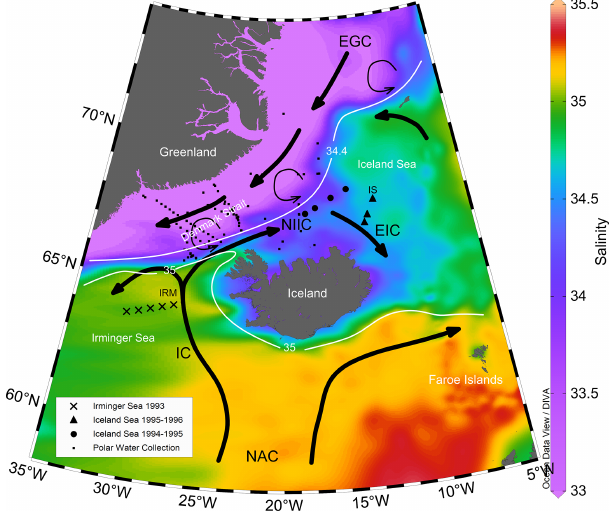
Figure 1. Mean July to September surface salinity in the vicin- ity of Iceland. The S = 35 isohaline marks the boundary between northward-flowing Atlantic Water and southward-flowing cold Arc- tic Water and low-salinity Polar Water. Stations in the Irminger Sea are marked with × , and stations in the Iceland Sea are marked with • for 1994–1995 and (cid:78) for 1995–1996 observations. Collection of Polar Water stations in 1983–2012 are marked with (cid:4) . IRM and IS mark the location of time series stations. NAC: North Atlantic Cur- rent; IC: Irminger Current; NIIC: North Iceland Irminger Current; EIC: East Icelandic Current; EGC: East Greenland Current. Map based on the NISE dataset (Nilsen et al., 2008) and drawn using the Ocean Data View programme (Schlitzer,